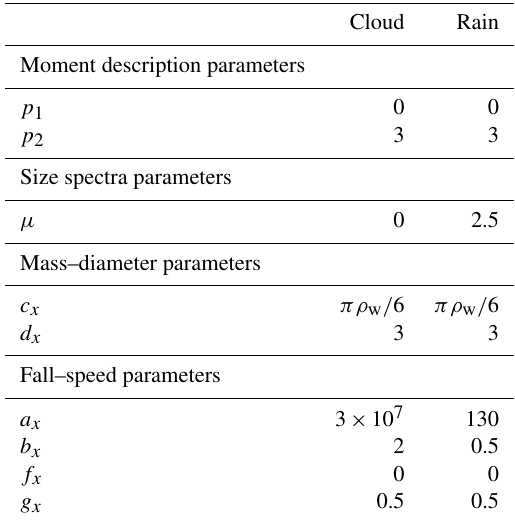
Table 3. The microphysical parameters used in the simulations for the equations described in Shipway and Hill (2012). ρ w is the den- sity of